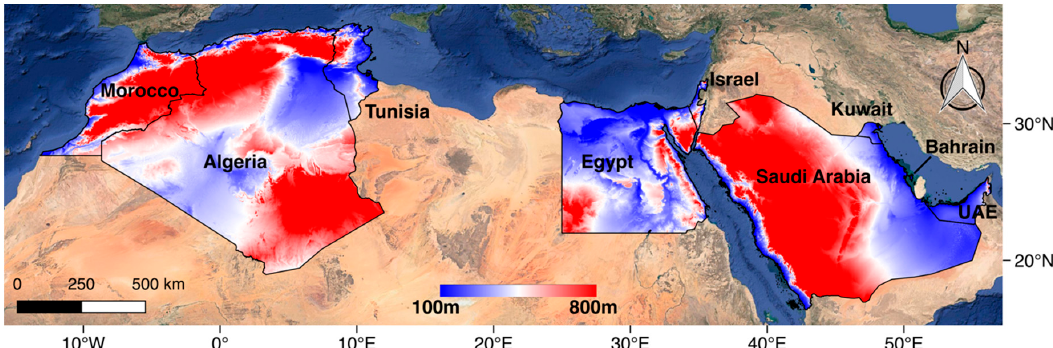
Figure 1. Location and topography map shows the selected countries of Middle East and North Africa (MENA) region, background image from Google Earth.